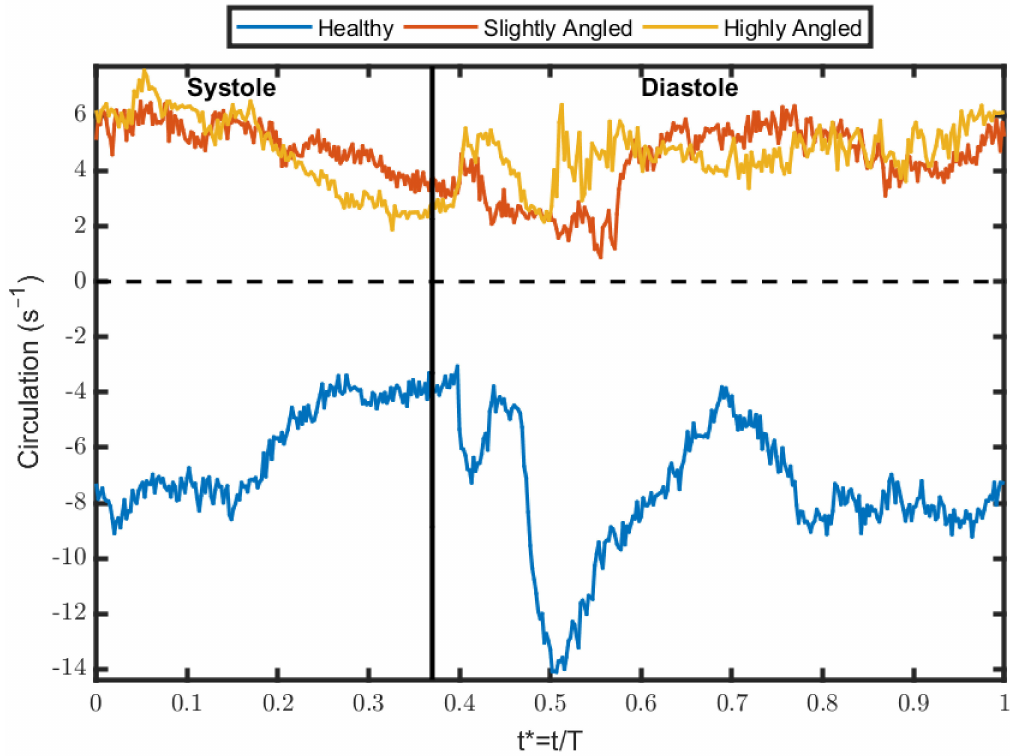
Figure 6. Circulation per unit area ( s − 1 ) of the flow. Adding a tilt to the mitral valve results in the flow to have a dominant counterclockwise direction. The vertical line separates the time period between systole and